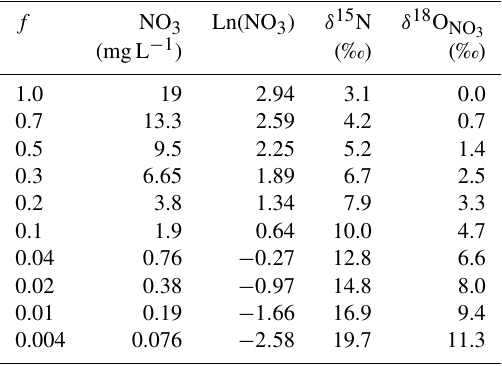
Figure 8. (a) Plot of δ 15 N versus δ 18 O NO . Group A and Group B are circled, and Group C and Group D are indicated by letters. (b, c) Plots 3 of δ 15 N and δ 18 O NO versus the natural log of the nitrate concentration. 3 Table 3. Results of calculations of the δ 15 N or δ 18 O values of ni- trate affected by denitrification. The initial nitrate concentration was = 19mgL − 1 , and the δ 0 values were δ 15 N = 3 . 1‰ and δ 18 O NO 3 0 . 0‰. The enrichment factors used were ε( 15 N ) = − 3 . 0‰ and ε( 18 O ) = − 2 . 1‰. f is the fraction of nitrate remaining after deni-